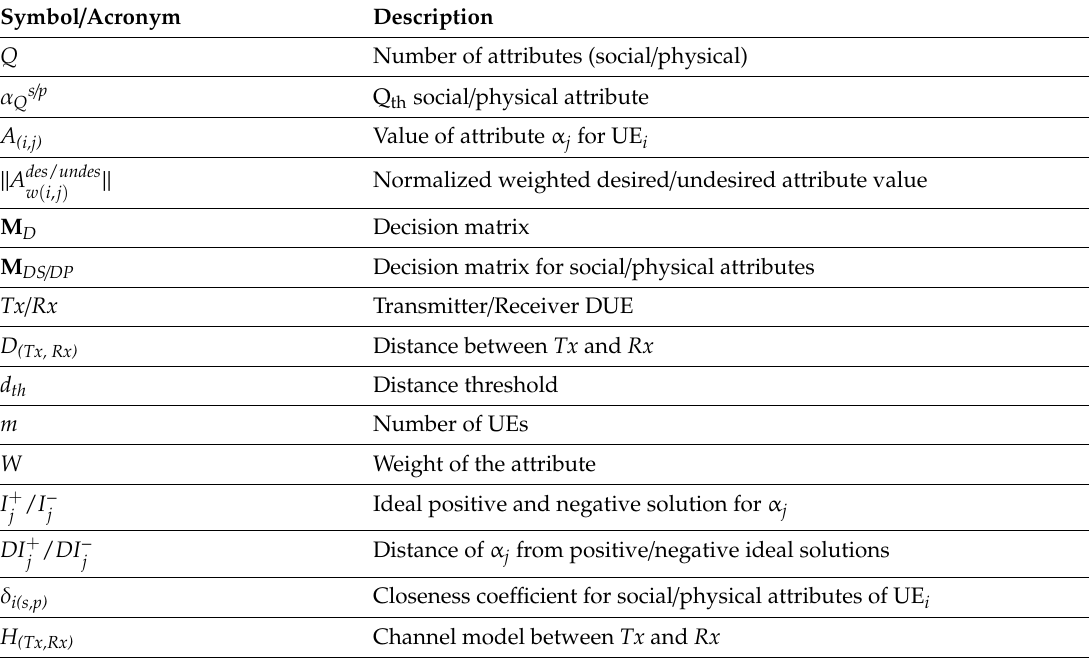
Table 1. List of notations and